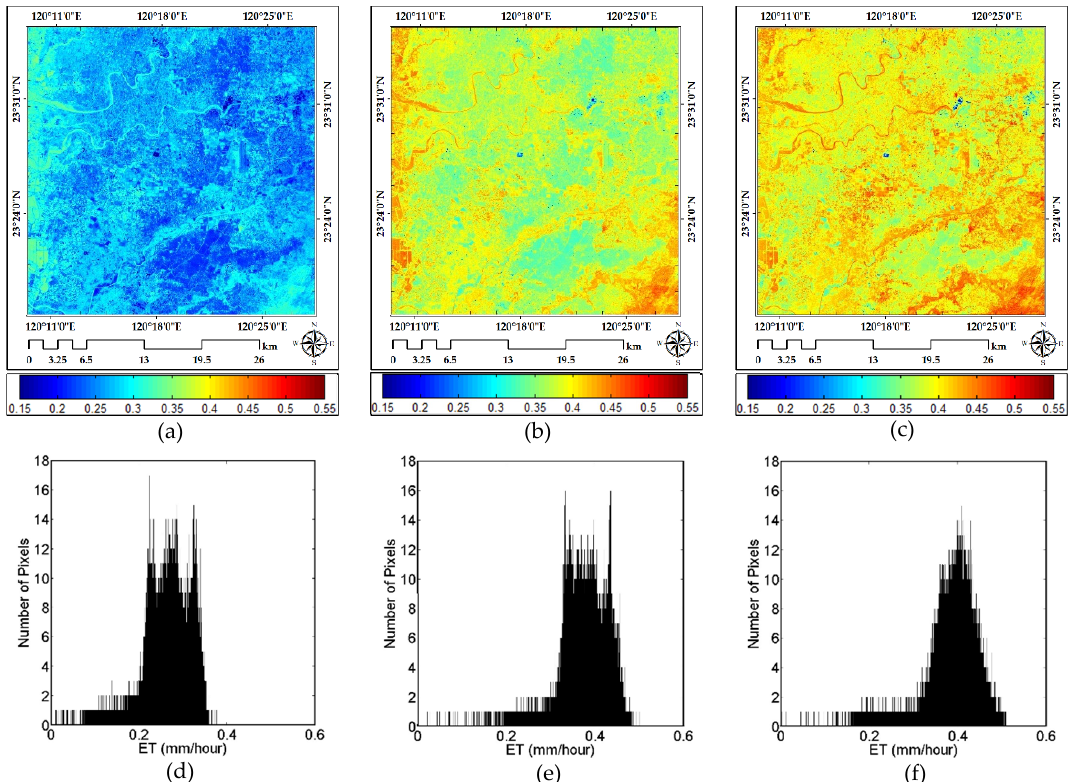
Figure 11. Same as Figure 8, but with the results of actual evapotranspiration (ET) (mm/hour) on 18 January 2019.